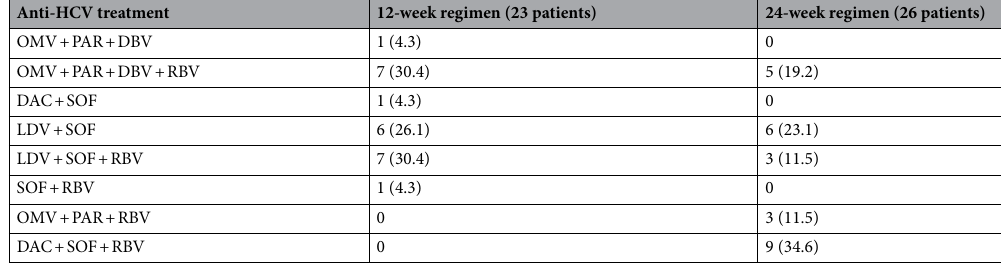
Patients with X4 infection (21, 42.9%) Patients with R5 infection (28, 57.1%) p